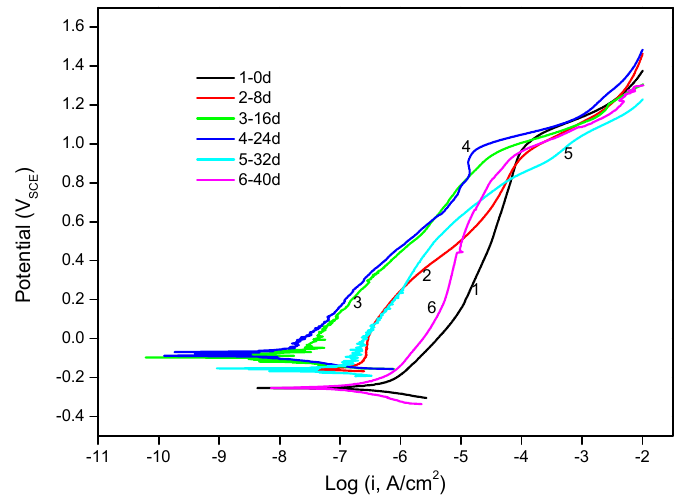
Figure 3. Potentiodynamic polarization curves in 3.5wt% NaCl for S32750 SDSS exposed in the simulated marine atmosphere for various days.